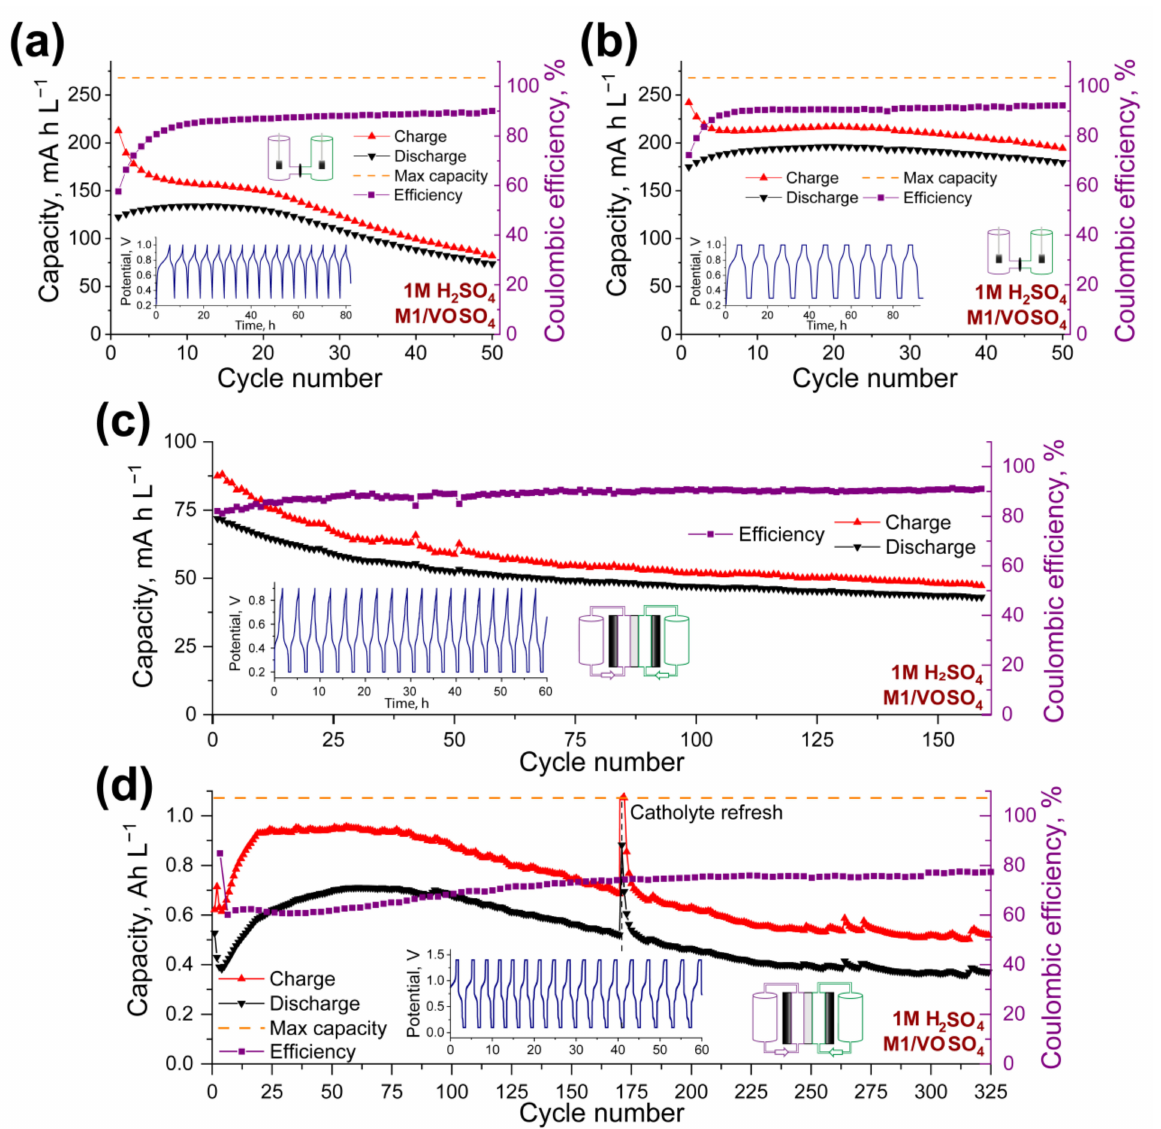
Figure 6. Electrochemical performance of h-cell with 5 mM M1 anolyte and 15 mM VOSO 4 catholyte in 1.0 M H 2 SO 4 water solution. Cyclic Coulombic efficiency, charge, and discharge capacity as the functions of a number of cycles are presented in the case of application of galvanostatic ( a ) and mixed galvanostatic + potentiostatic mode with the delay at the maximum and minimum potential of 2 h ( b ). ( c ) Electrochemical performance of the RFB with 3 mM M1 anolyte and 10 mM VOSO 4 catholyte in 1.0 M H 2 SO 4 water solution during 160 cycles. Cyclic Coulombic efficiency, charge, and discharge capacity as the functions of a number of cycles are presented. ( d ) Electrochemical performance of the RFB with 20 mM M1 anolyte and 60 mM VOSO 4 catholyte in 1.0 M H 2 SO 4 water solution